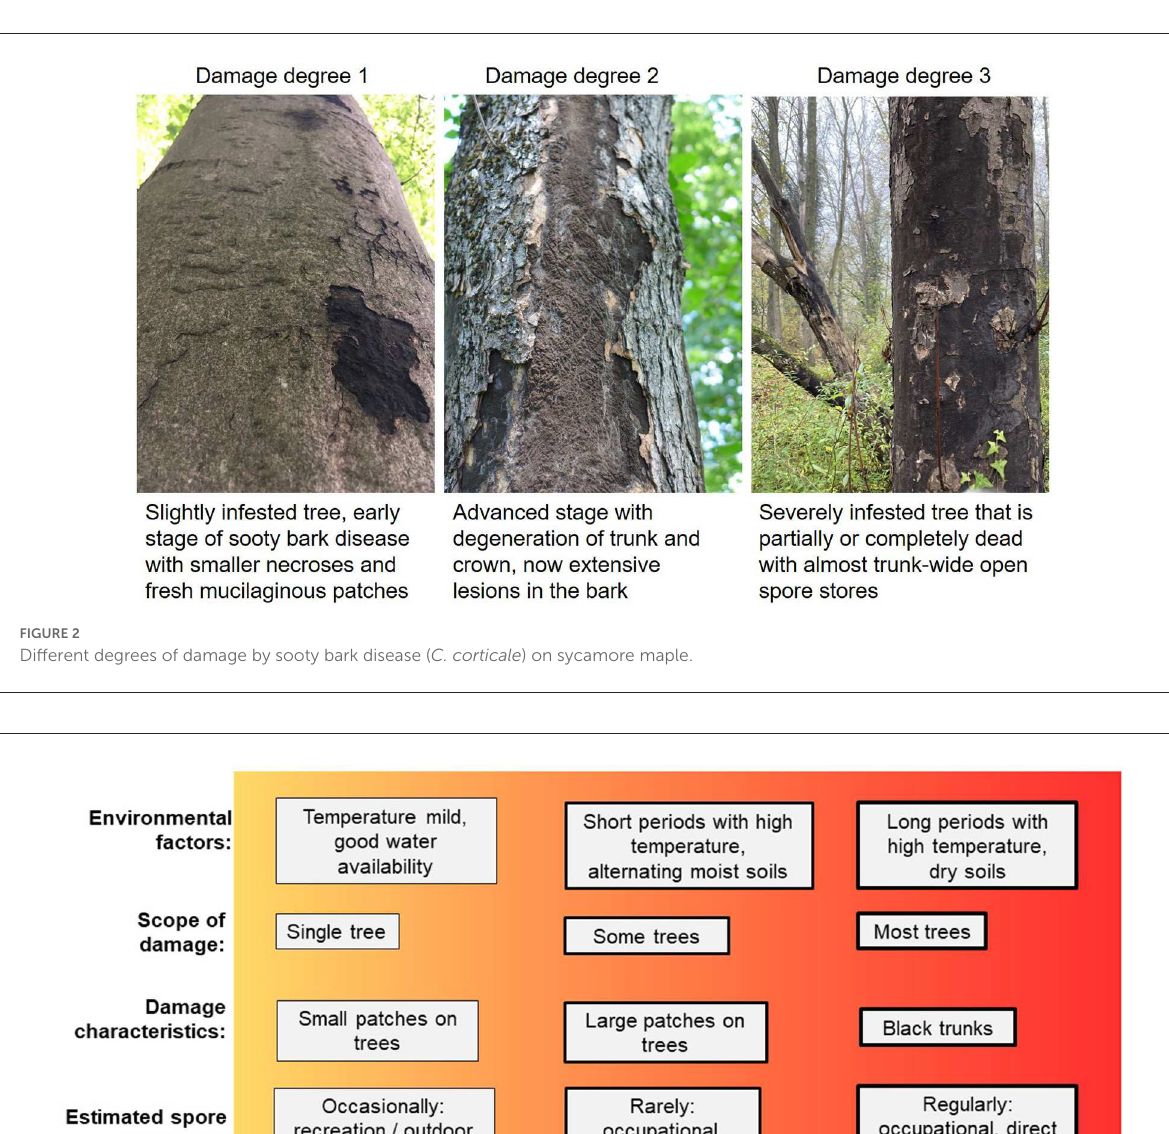
drugs, low molecular weight chemicals, bacteria/molds/yeasts (microbial components) (33). Exposure to these potential antigens can occur at home or during leisure time as well as during work. HP is a rare disease with incidences about 0,9 cases per 100,000 persons (general population) per year (34); among